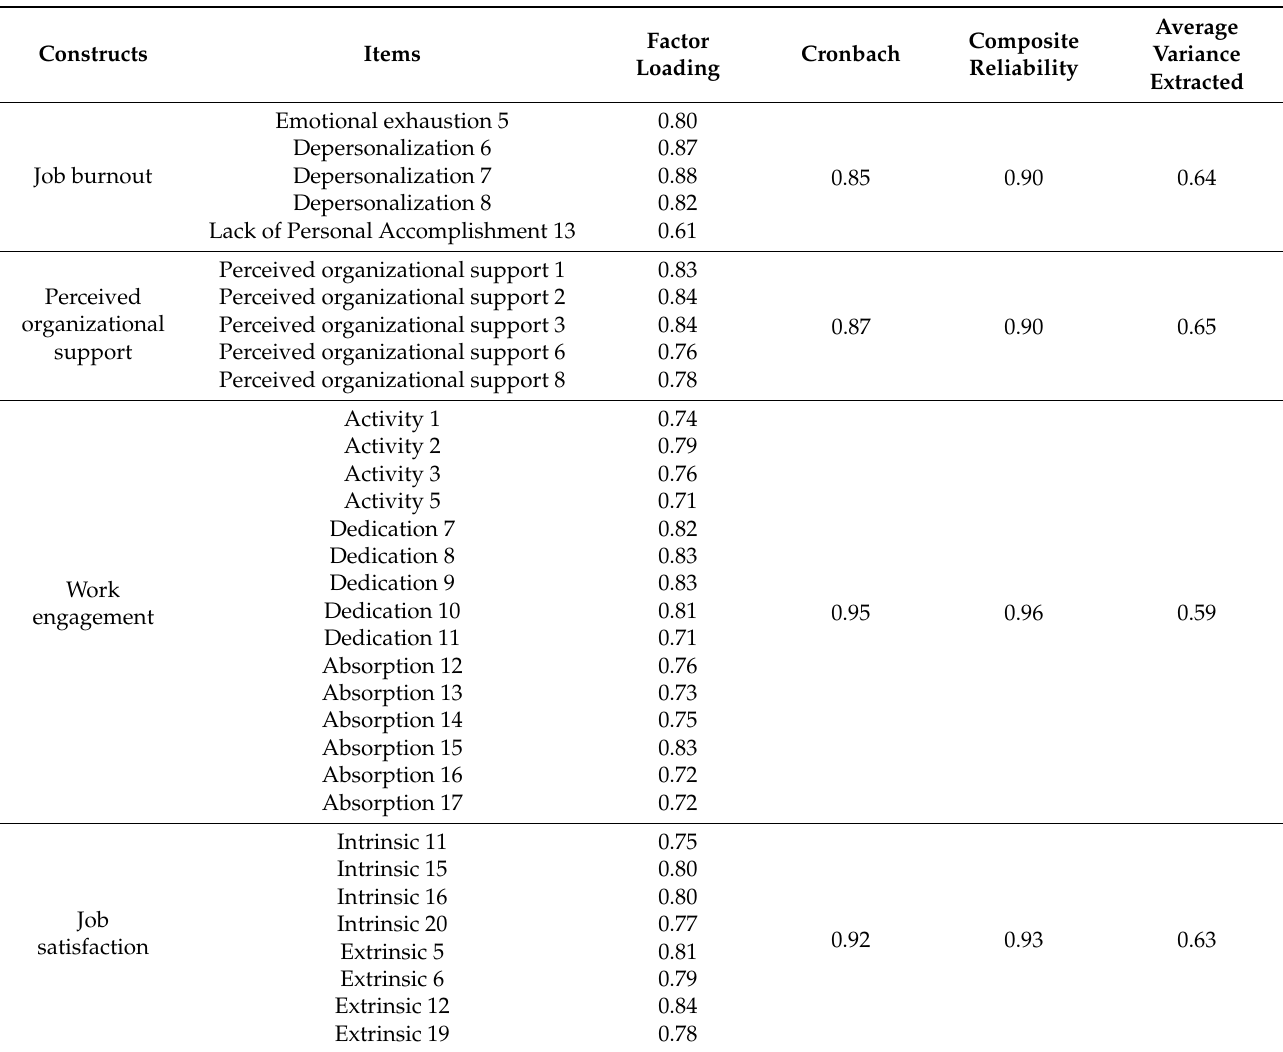
Table 5. Results of measurement model test.